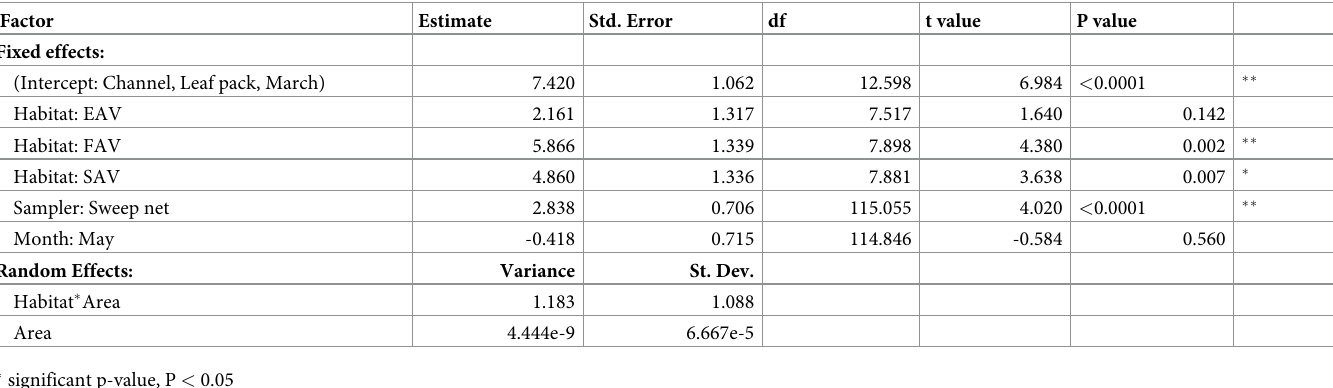
Table 4. Coefficients for the linear mixed model predicting taxa richness of sweep nets and leaf packs Model: Catch ~ Habitat + Sampletype + Month + Error(Area/ Habitat). The interaction term was not significant and so was dropped from the final model. Factor Estimate Std. Error